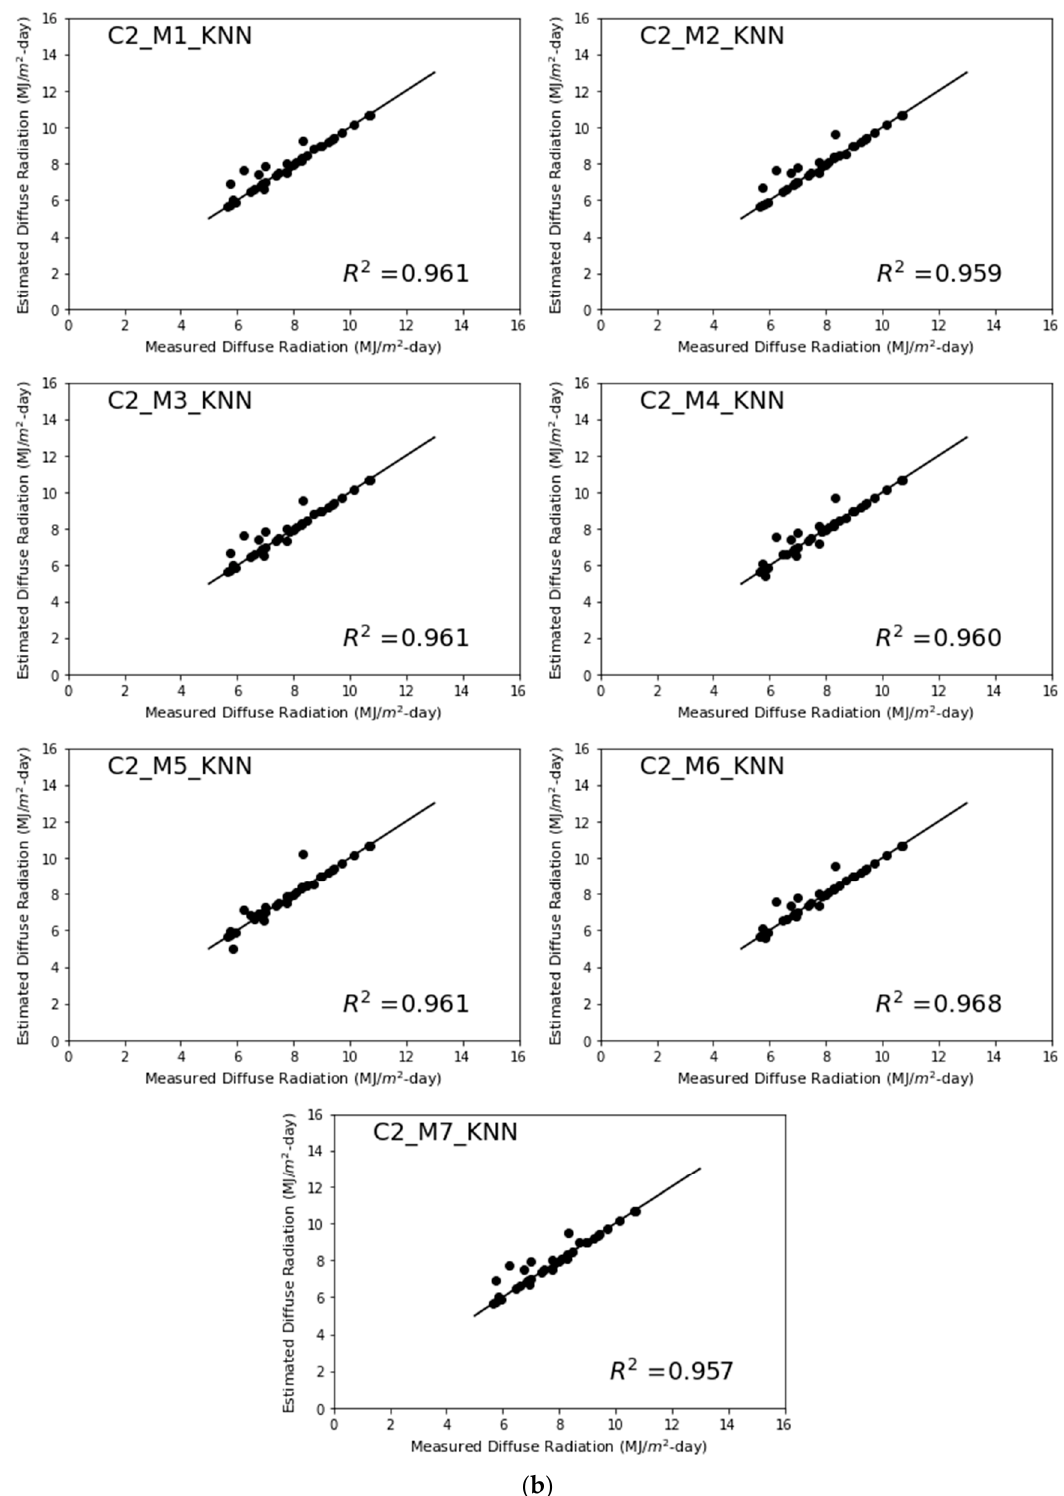
Figure 10. ( a ) Plot depicting predicted and measured DSR tropical wet climate (Category I). ( b ) Plot depicting predicted and measured DSR tropical wet climate (Category 2).